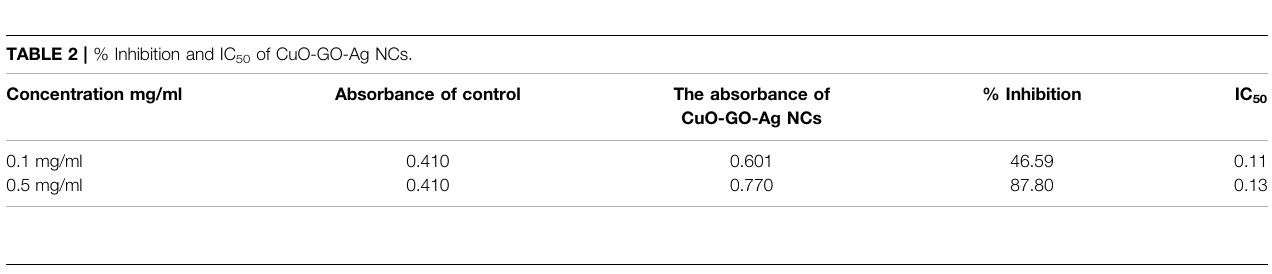
TABLE 3 | Percent scavenging and standard IC50 (ascorbic acid).